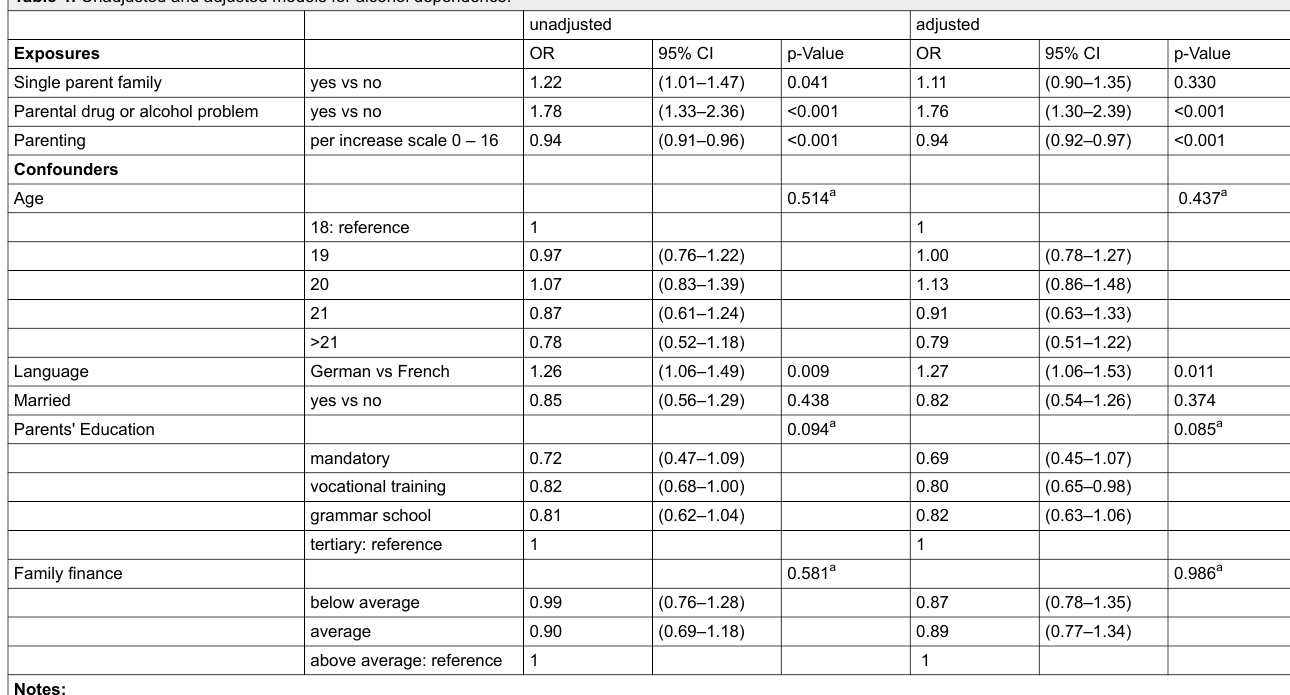
Table 4: Unadjusted and adjusted models for alcohol dependence.